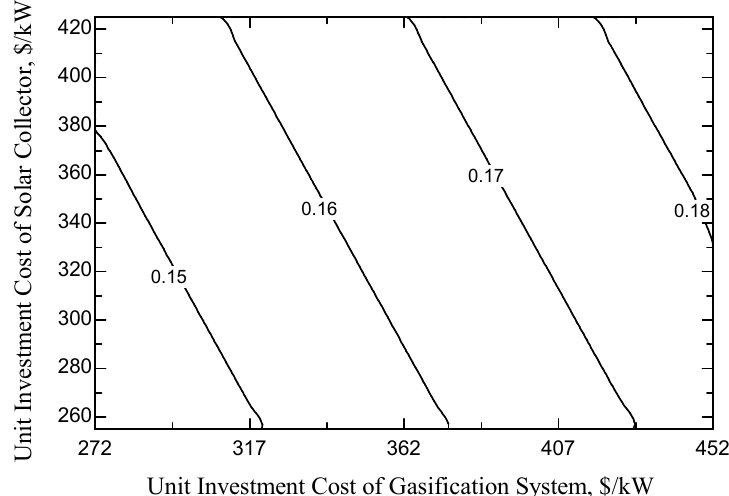
Figure 7. Variations of unit exergy cost of electricity with investment of the Solar heat collector (SHC) and the gasification